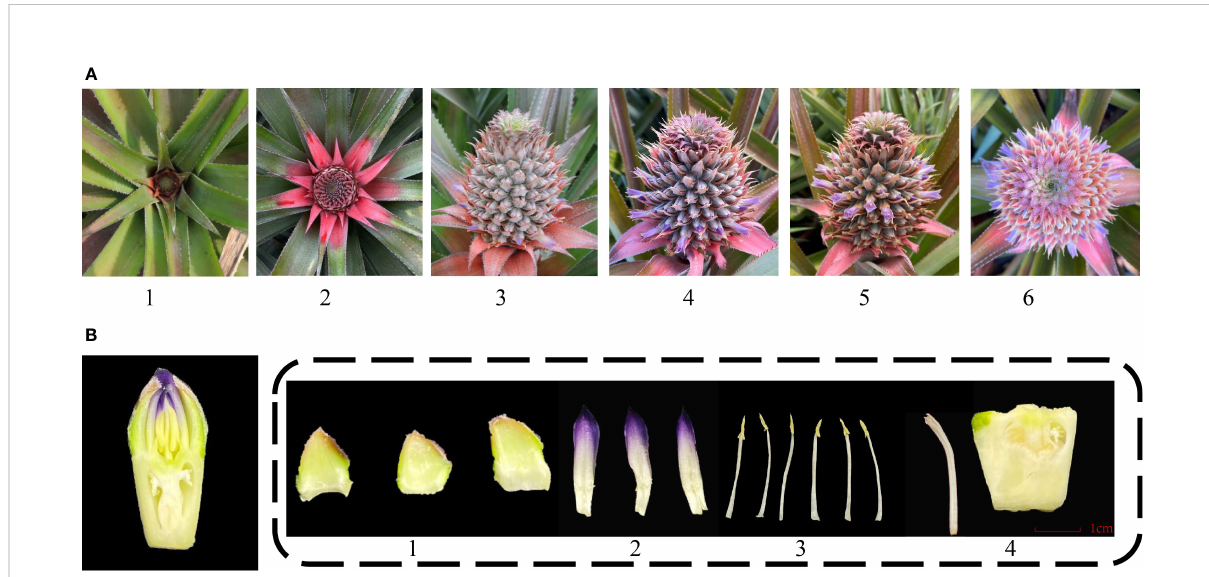
FIGURE 1 Different stages and organs of pineapple fl oral development. (A) Different developmental stages of in fl orescence. 1. In fl orescence emerging; 2. In fl orescence swelling out; 3. Early fl owering stage; 4. Full-bloom stage; 5. Flower fading stage; 6. Panoramic view of the full-bloom stage. (B) Floral organ structure of pineapple. 1. Sepal; 2. Petal; 3. Stamen; 4.